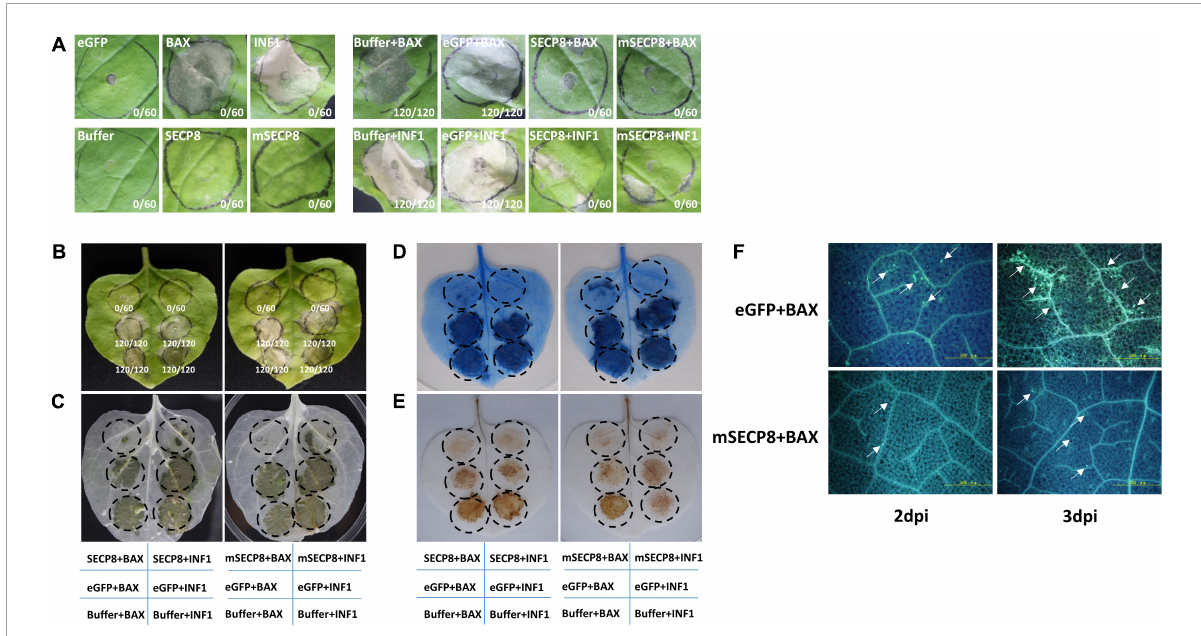
FIGURE2 Cell death, H 2 O 2 accumulation and callose deposition suppressed by mSECP8. (A,B) The SECP8 or mSECP8 suppressed the hypersensitive cell death triggered by BAX and INF1 in Nicotiana benthamiana . The Agrobacterium GV3101 (pJIC SA_Rep) strain harboring SECP8 , mSECP8 , eGFP , BAX , and INF1 , or inoculation buffer were infiltrated into the leaves of N. benthamiana , either alone or followed 24 h later with GV3101 carrying BAX or INF1 within the regions marked by the dashed circle. Numbers in the photos, for instance 0/60, indicated that no infiltration spot exhibited cell death out of 60 infiltration spots. The leaves were harvested at 7 days after infiltration BAX and INF1 , followed by (C) decolorization with ethanol and (D) trypan-blue staining (blue-stained tissues indicated dead cells). (E) SECP8 or mSECP8 inhibited burst of H 2 O 2 triggered by BAX and INF1. Samples were detached at 2 days after transient expression of BAX and INF1 for 3,3 (cid:48) -diaminobenzidine (DAB) staining. (F) SECP8 or mSECP8 suppressed accumulation of callose caused by BAX. Leaves inoculated with BAX at 2 and 3 days later were sampled for aniline-blue staining. Scale bars represent 500 µ